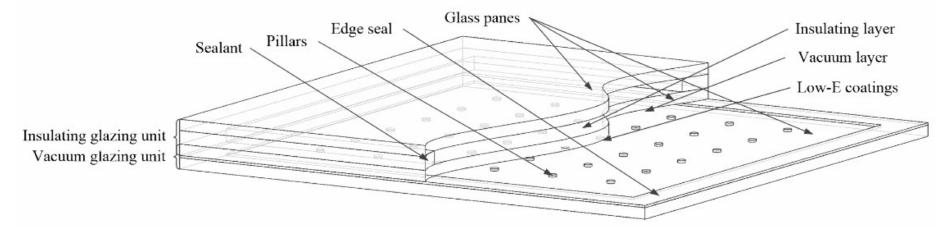
Figure 1. The general structure of